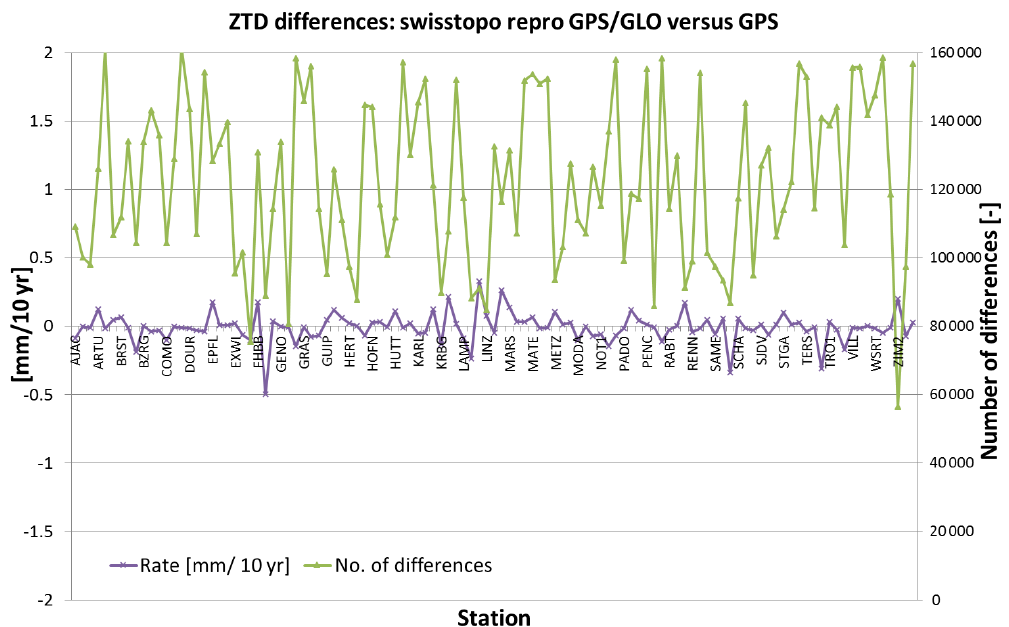
Figure 2. ZTD trend differences between GPS only and GPS/GLONASS, computed over 111 sites. The rate is in violet (primary y axis) and the number of used differences is in green (secondary y axis).